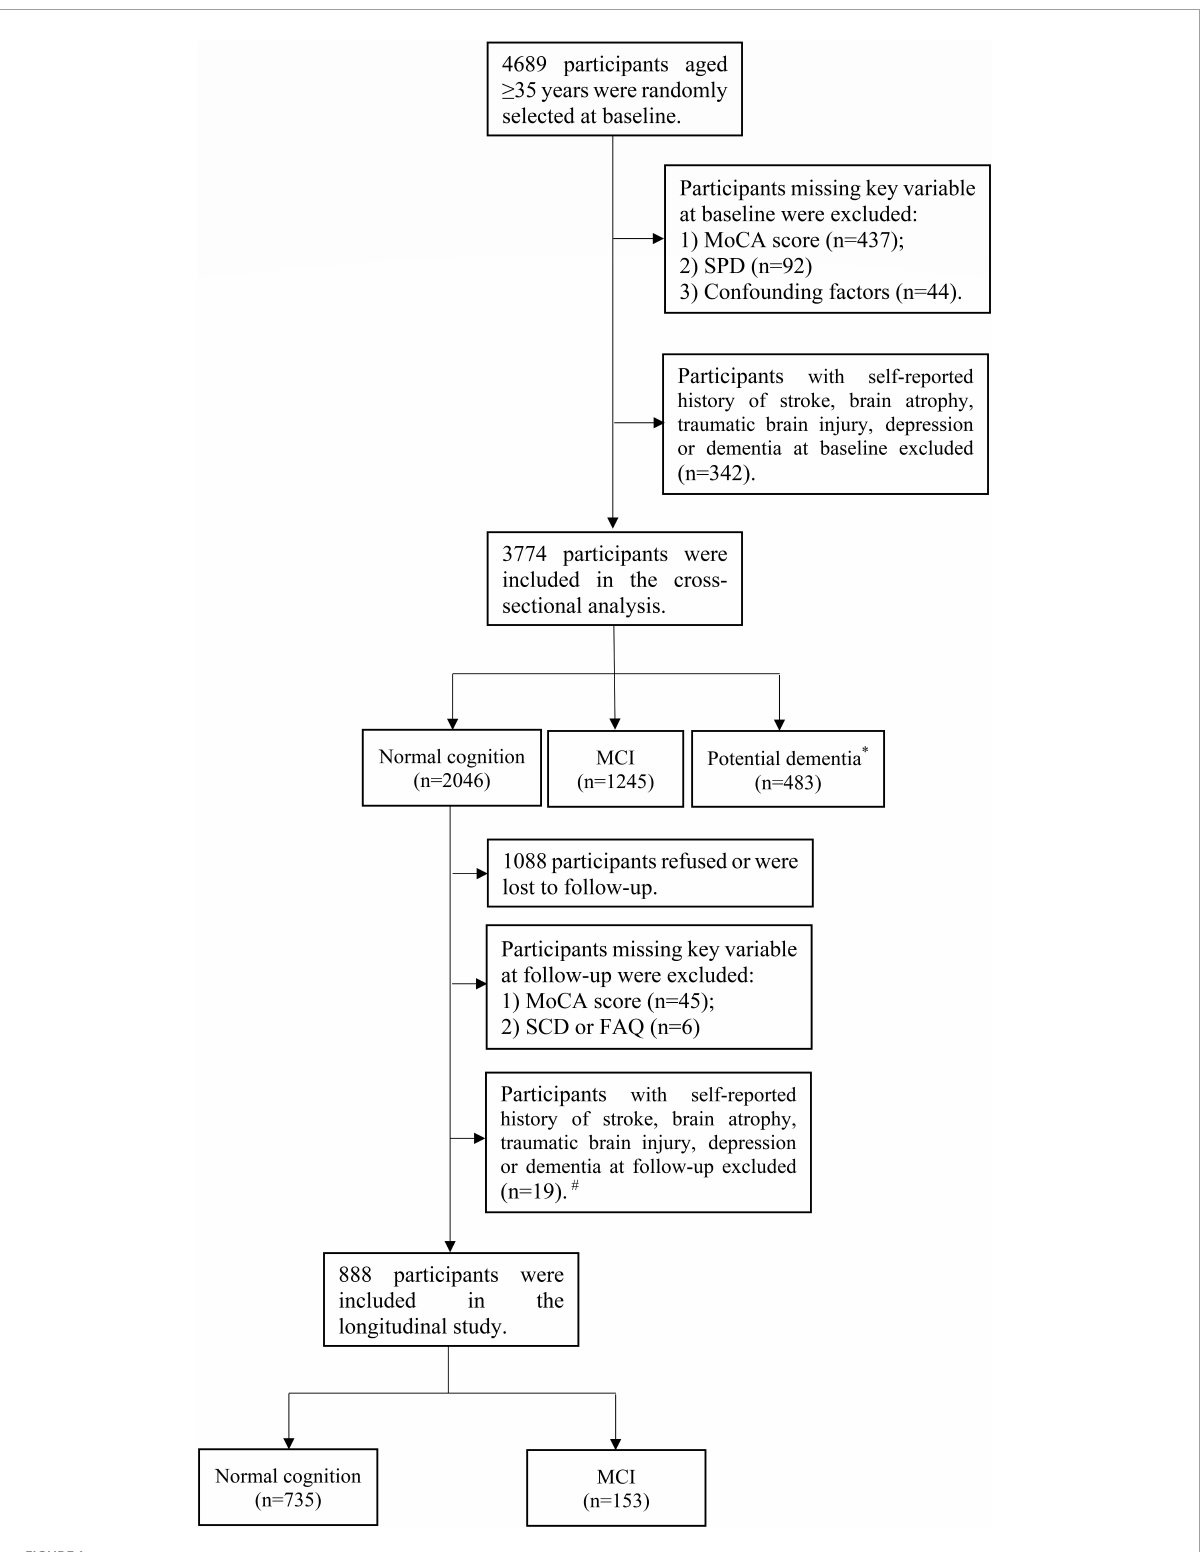
FIGURE1 Flowchart of the participants included in the current analysis. *Potential dementia was defined following MoCA-BC. # Dementia was diagnosed following the criteria of the NIA-AA workgroup.